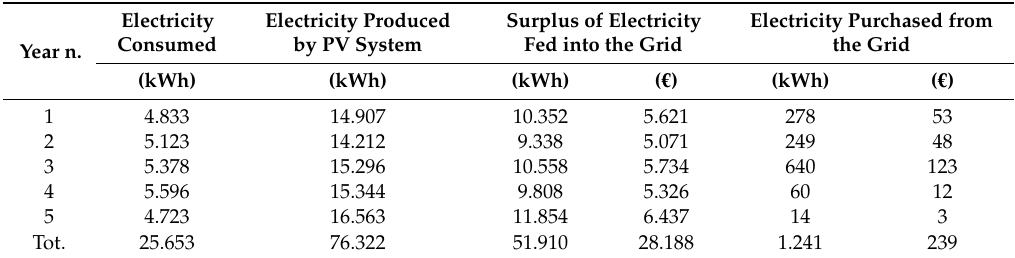
Table 8. Energy data on electricity consumption and photovoltaic (PV) production for five years (June 2014–June 2019).